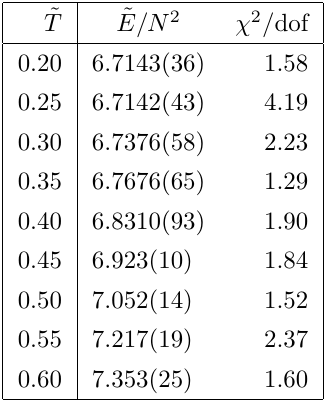
values for the gauged theory were presented in ref. [11] and were (cid:12)tted